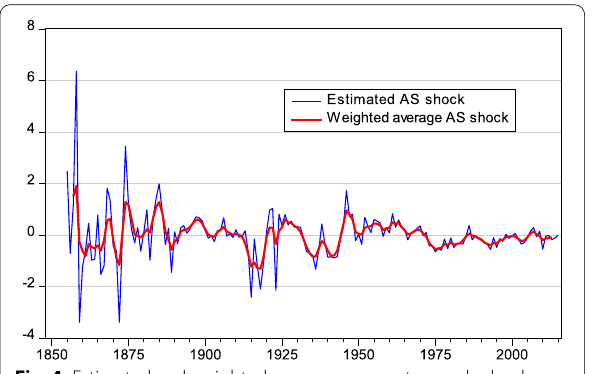
Fig. 4 Estimated and weighted average aggregate supply shock Fig. 5 Estimated and weighted average aggregate demand